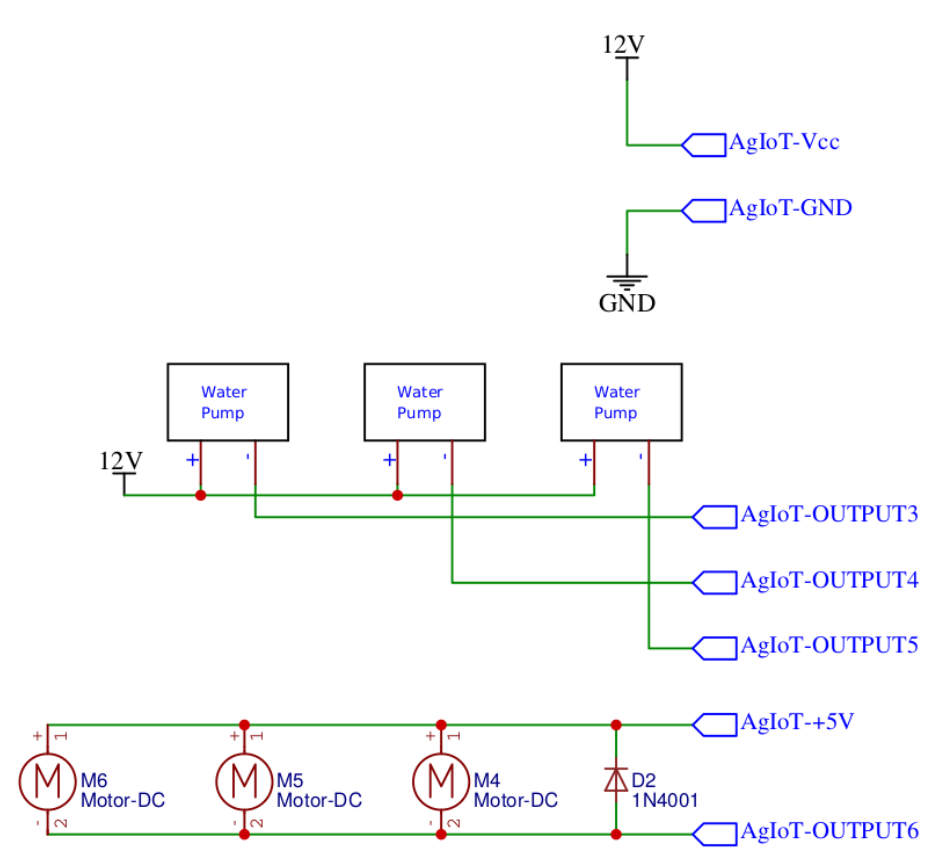
Figure 3. PRYSM sprayer electrical schematic: brushless motors and controllers ( top ), AgIoT power supply ( center ), and water pumps and DC motors supply ( bottom ).